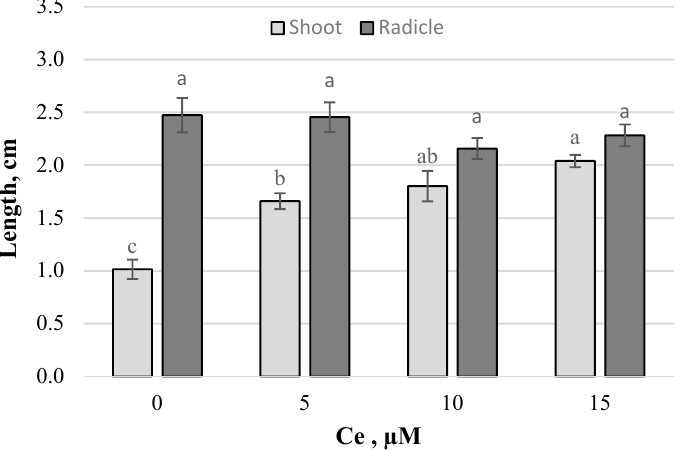
Figure 2. Shoot and radicle length of tomato ( Solanum lycopersicum L.) cv. Vengador seedlings after seven days in germination chambers in solutions with different Ce concentrations. Means ± SDs with different letters in each parameter indicate significant statistical differences (LSD, 0.05).